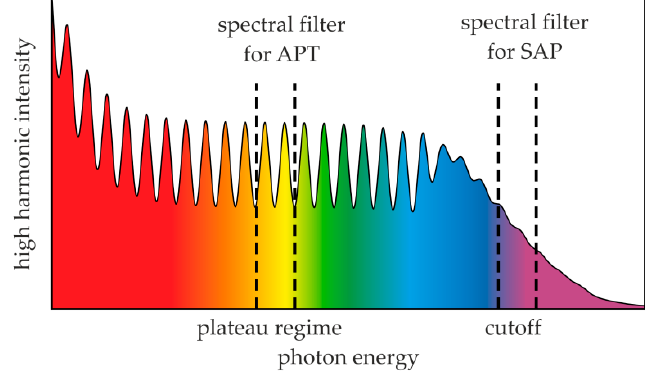
Figure 2. Schematic high harmonic spectrum of a few-cycle IR pulse. In the intermediate energy regime, separated harmonic lines of equal height form a plateau. Spectral filtering in this regime leads to EUV APTs. In the high-energy regime, a cutoff continuum is formed. To obtain SAPs, this regime needs to be spectrally filtered.